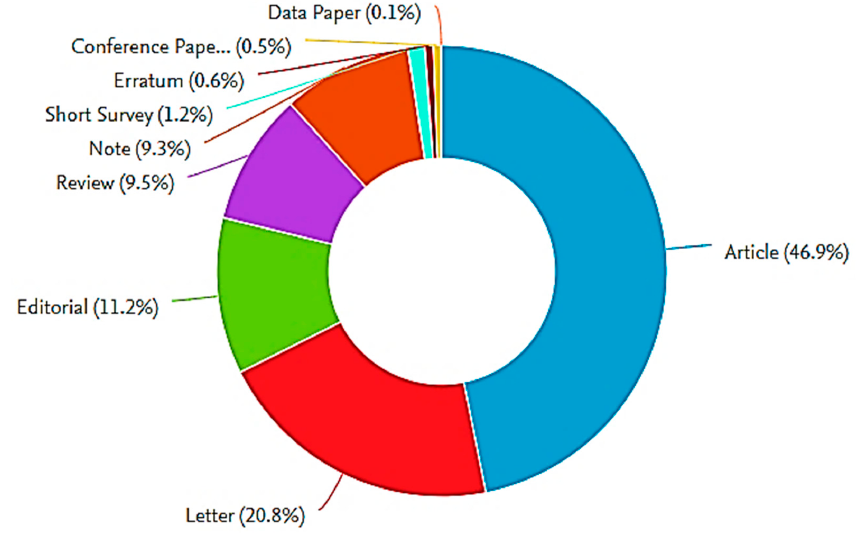
Figure 1. Types of documents published on COVID-19 disease (from Scopus Database).